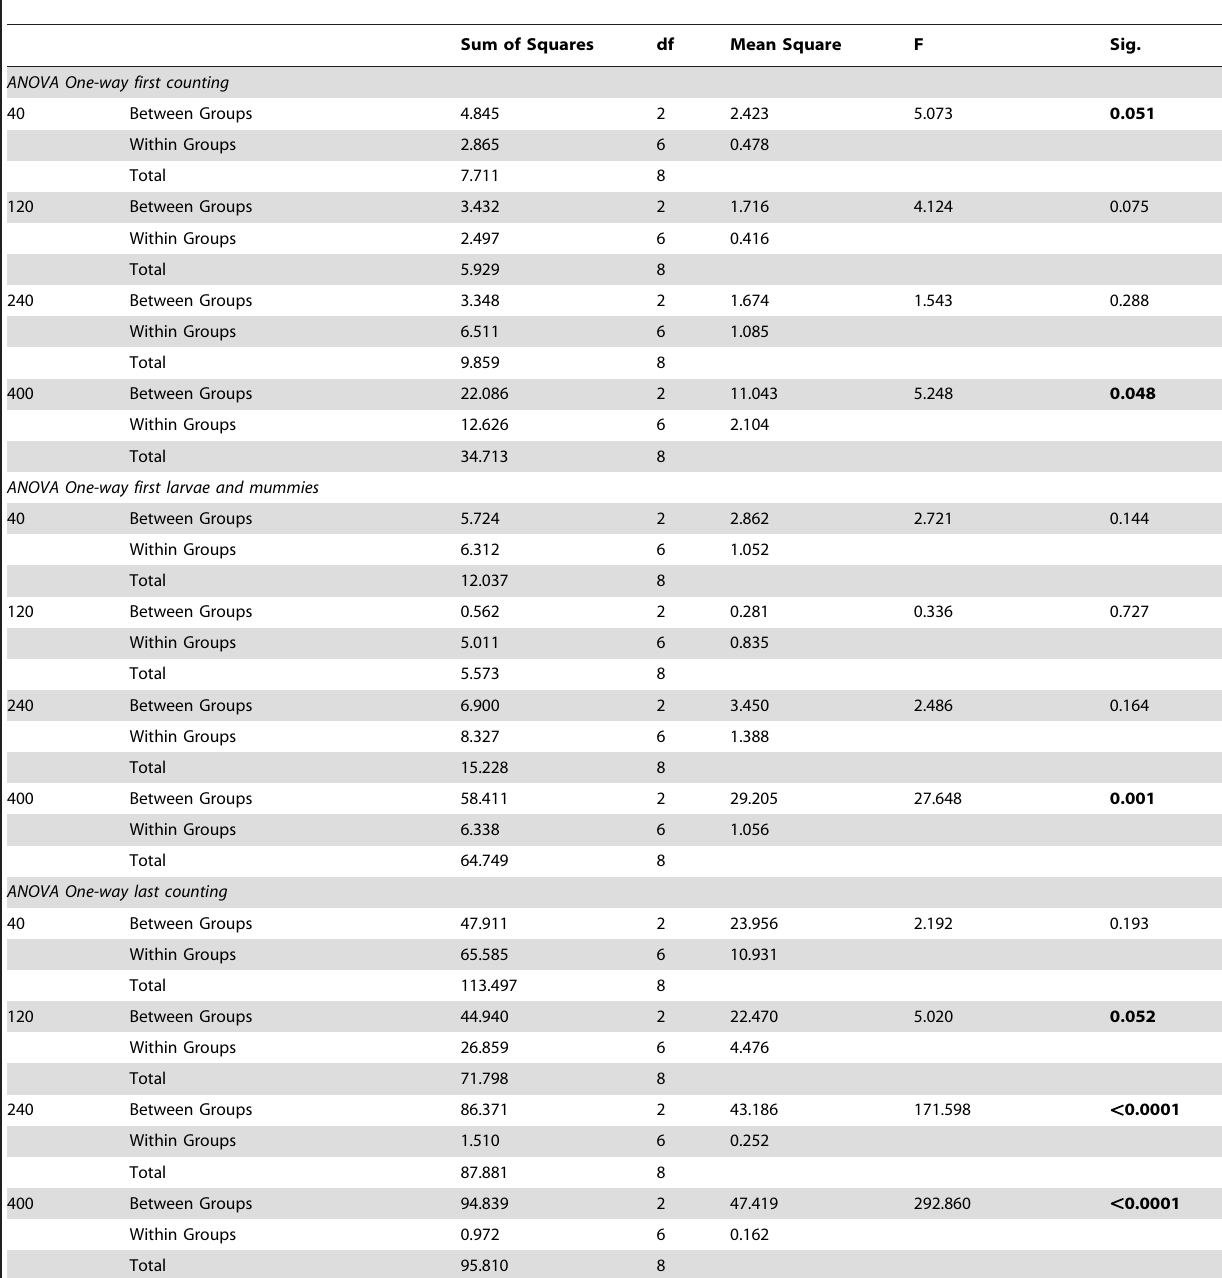
Table 4. One way ANOVA of 3 different counts (first count, time of first larvae and mummies appeared and last count).